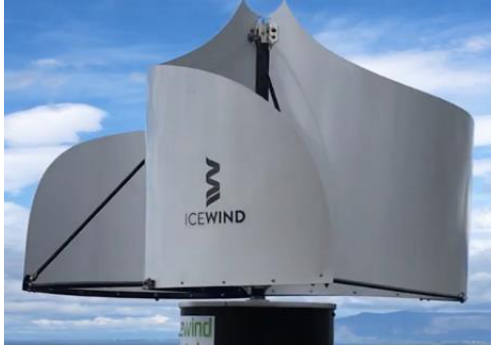
Figure 1. CW IceWind turbine.